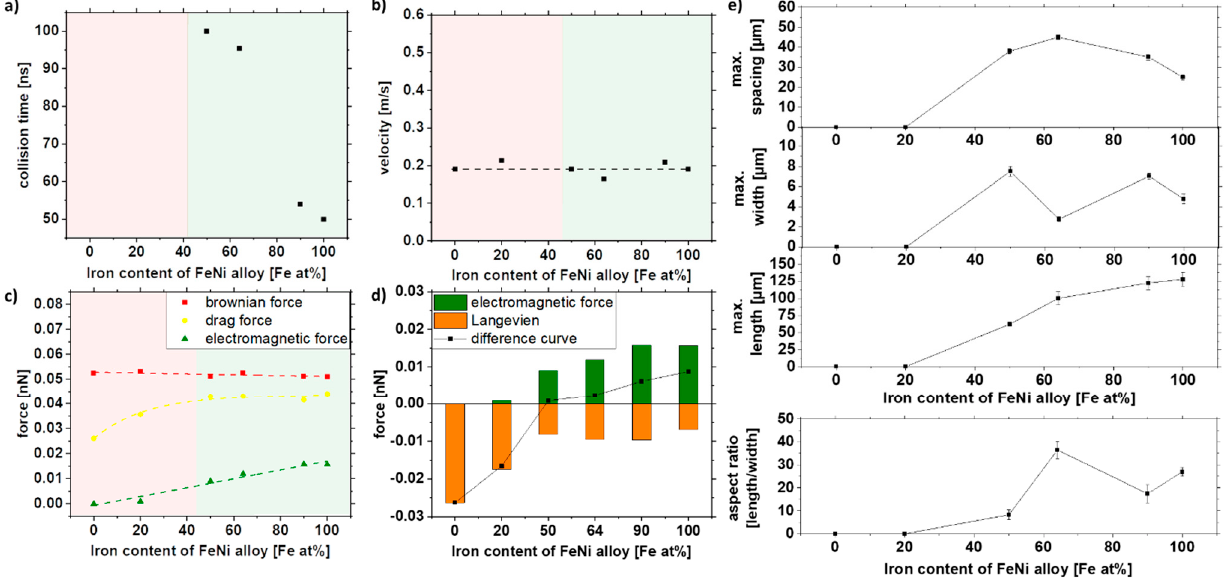
Figure 9. COMSOL simulation data of ( a ) collision time, ( b ) velocity, and ( c , d ) forces in dependence of the iron content of the FeNi alloy and experimental validation of ( e ) length, width, spacing, and aspect ratio of strands as a function of the iron content of the FeNi alloy in 5% PMMA solution.